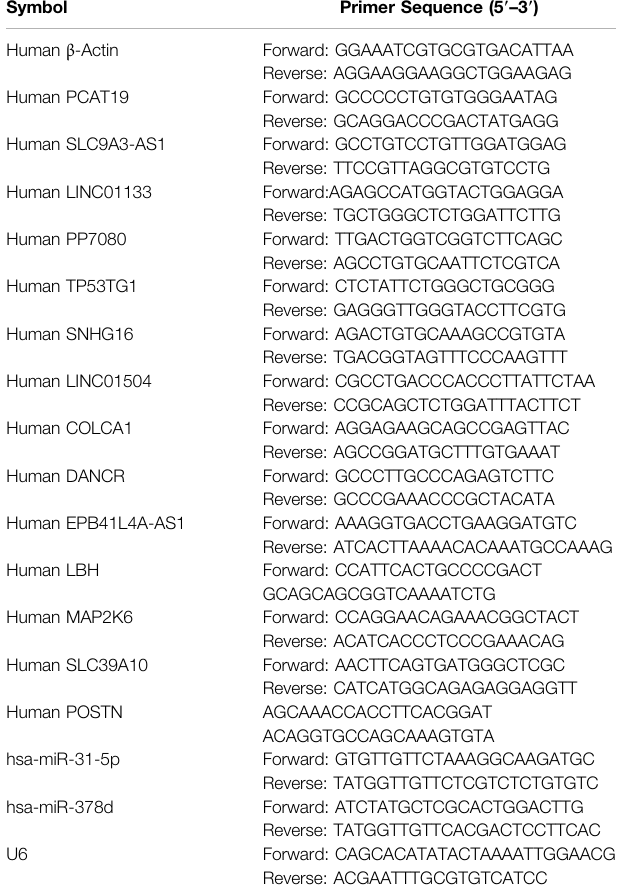
TABLE 1 | Primers for